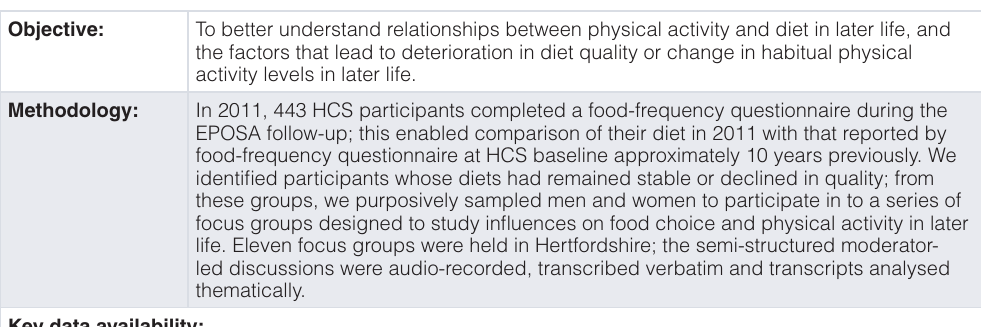
Table 11. Hertfordshire Cohort Study diet and physical activity focus groups.